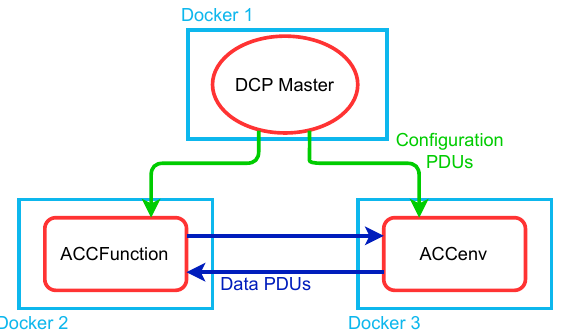
Figure 7. Deployment of the simulation scenario of use case 1, each participant in the simulation is deployed in its own docker